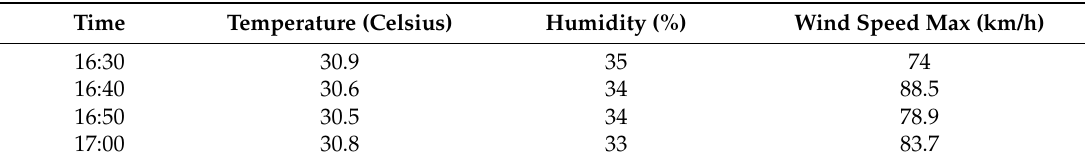
Table 5. Sample of weather condition measurements for the area where the wild fire was ignited